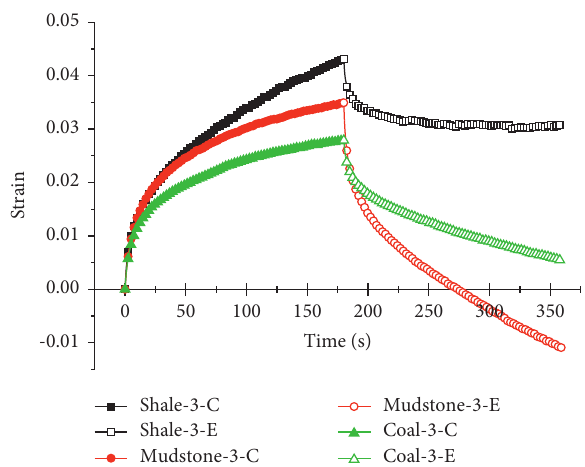
Figure 3: Nanoindentation rheological strain-time curves of shale-3, mudstone-3, and coal-3 including creep (-C) and elastic aftereffect (-E).